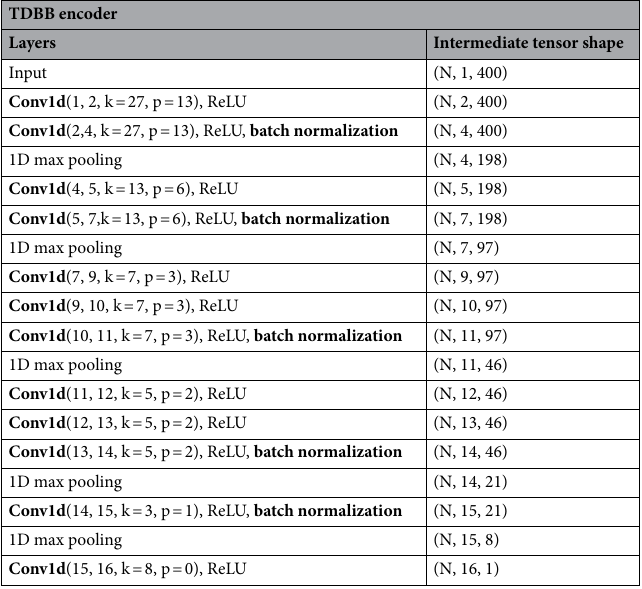
Table 1. Time domain black box (TDBB) encoder network parameters. The convolutional layers were designed to act as a series of discrete filters with trainable parameters. N is the batch number of the input tensor. Trainable layers are given in bold.